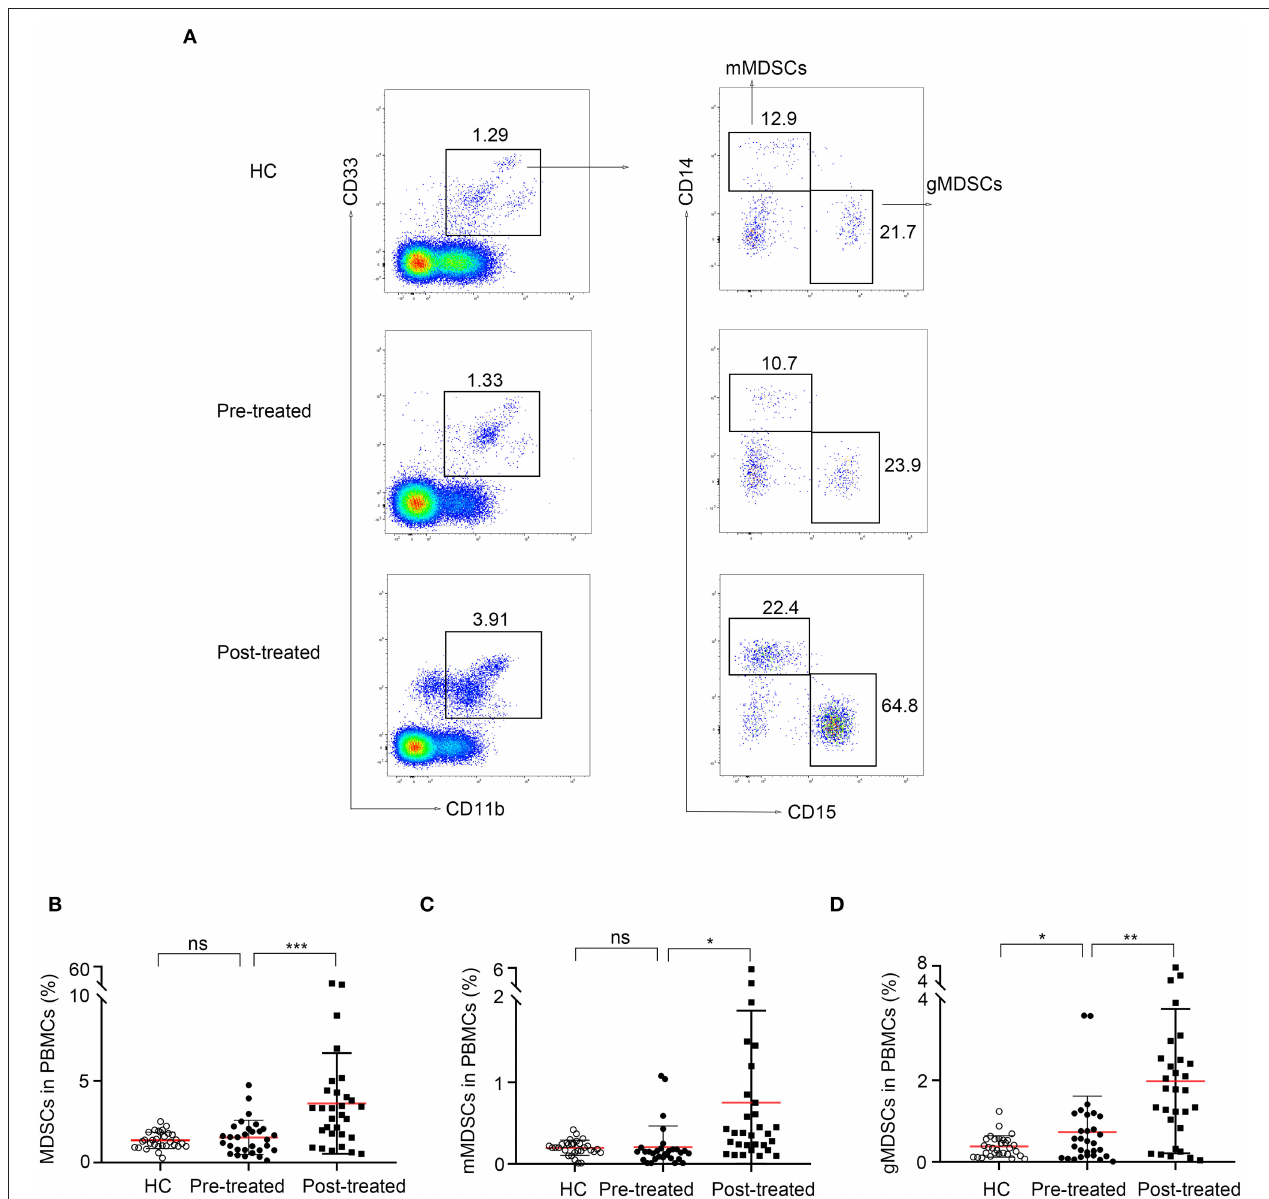
FIGURE 2 | Expansion of MDSCs in patients with myasthenia gravis (MG) after immunotherapy. (A) Representative data plots of MDSCs, mMDSCs (HLA-DR − / low CD33 + CD11b + CD14 + ) and gMDSCs (HLA-DR − / low CD33 + CD11b + CD15 + ) from healthy controls (HC), patients with MG before (pre-treated) and after immunotherapy (post-treated). No difference of frequencies of MDSC (B) and mMDSCs (C) in PBMC between untreated patients with MG and HCs, but an increased frequency of gMDSC (D) in untreated patients with MG. The frequency of MDSCs (B) , both mMDSCs (C) and gMDSCs (D) was significantly increased after immunotherapy. Horizontal lines and error bars represent mean ± SD, n = 30, * p < 0.05, ** p < 0.01.